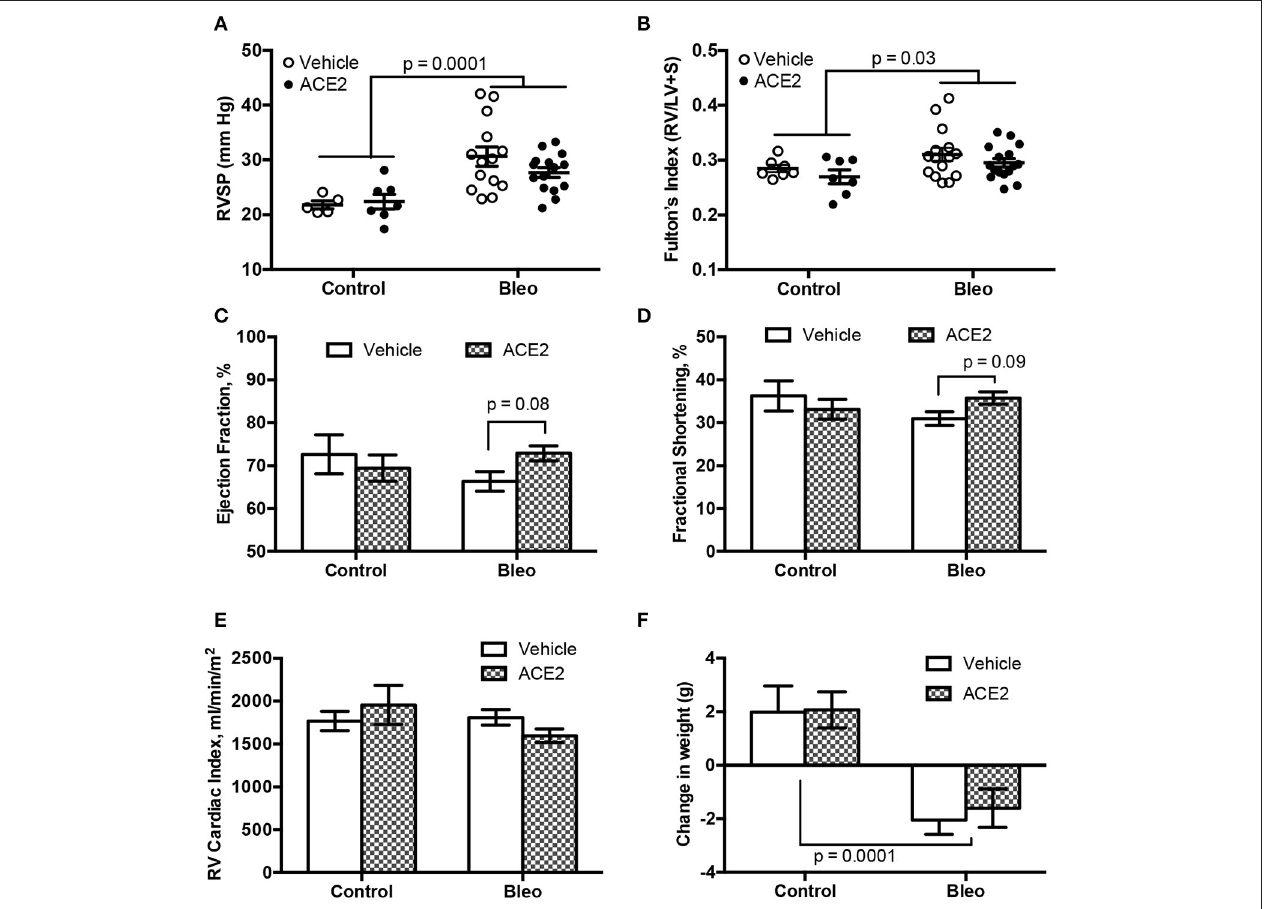
FIGURE 2 | RVSP and cardiac function in group 3 PH animals. RVSP, measured by RV catheterization, and hypertrophy, measured by Fulton’s index, both increase with bleomycin treatment (A,B) . ACE2 significantly improved the fractional shortening and ejection fraction in bleomycin-treated animals, compared with vehicle (C,D) , while there was no change in RV cardiac output normalized for weight across groups (E) . ACE2 did not significantly decrease the weight loss associated with Bleo treatment (F) . Data are mean ± SEM; n = 7, 7, 15, and 16 for the control, ACE2, Bleo and Bleo + ACE2 groups respectively in (B–F) , and n = 5, 7, 14, and 15 in (A) . Comparisons shown are the result of two-way ANOVA followed by Holm-Sidak’s post-test.